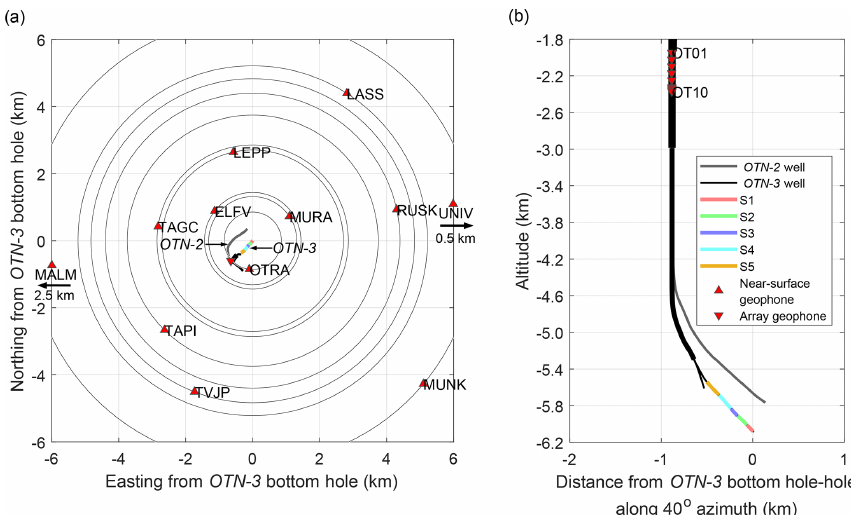
Figure 1. Seismic network used for monitoring the stimulation in 2018. (a) Map view showing the near-surface geophones framing the EGS site with the injection borehole OTN-3 and the OTN-2 well drilled in 2019 and 2020. The radius of concentric circles represents the distance between the end of the OTN-3 borehole and each station. (b) Side view of the boreholes with the geophone array placed at the already existing part of the OTN-2 well. The injection intervals S1–S5 of the stimulation in 2018 are color-coded at the end of the injection borehole. For further details about the location of the EGS site in the suburban area of Helsinki in Finland, see Kwiatek et al.